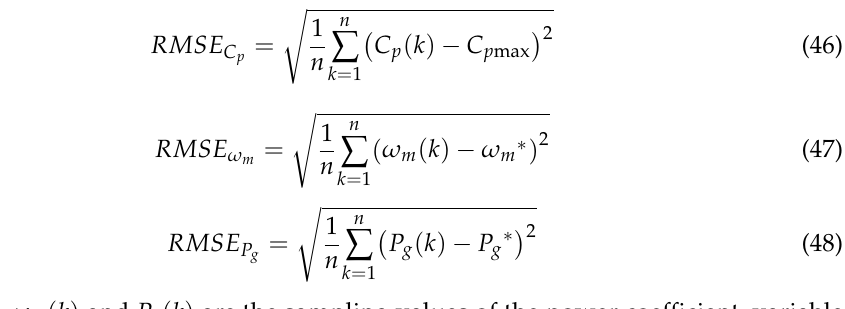
Figure 5. Comparison of power coefficients and variable motor speeds under different control methods in scenario 2: ( a ) power coefficient; ( b ) absolute error of power coefficient; ( c ) variable motor speeds; ( d ) absolute error of variable motor speeds.